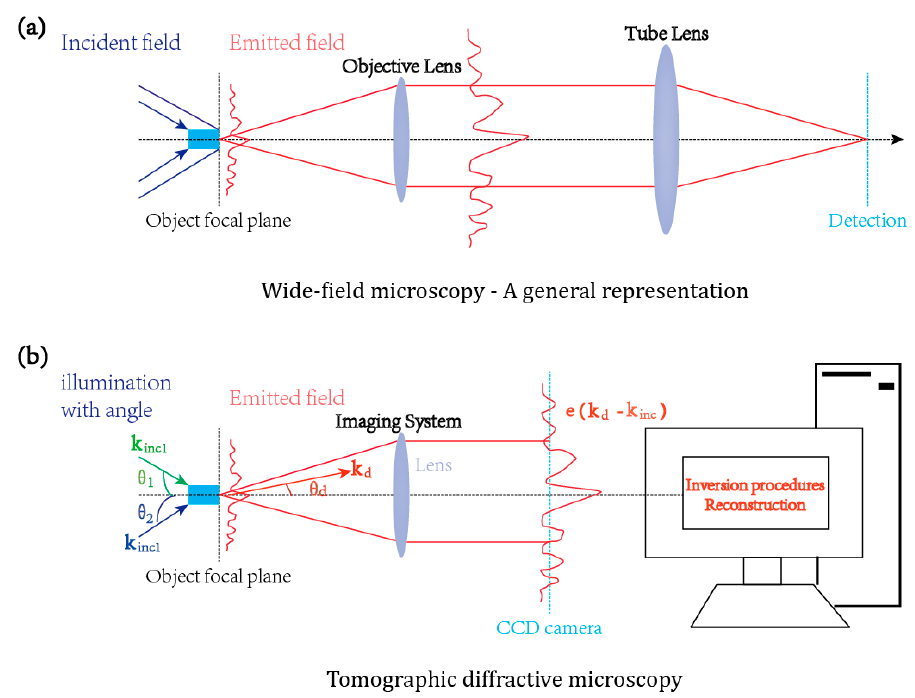
Figure 1. Schemas of the wide-field microscopy and tomographic diffractive microscopy. ( a ) Wide-field microscopy. ( b ) Tomographic diffractive microscopy.